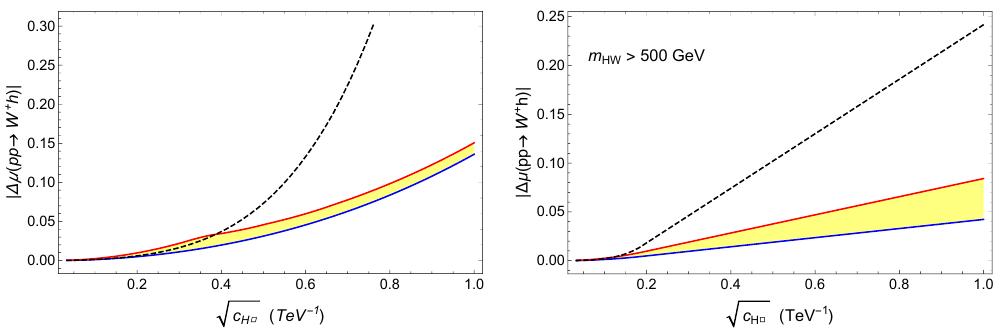
Figure 4 . Deviation in the inclusive (left panel) and high-mass (right panel) (cid:27) ( pp ! h W + ) cross p sections at the LHC ( s = 13 TeV) assuming the only non-zero dimension-6 operator is O (3) adding in all dimension-8 operators with equal magnitude coe(cid:14)cients and mixed signs as in the bottom panel of (cid:12)gure 2. The blue, red, and dashed black lines correspond to the same scenarios as in (cid:12)gure 2. The current limit on c (3) at 95% CL is 0 : 66 TeV (cid:0) 1 [90]; we have zoomed in to make HQ the dimension-8 contribution more visible.